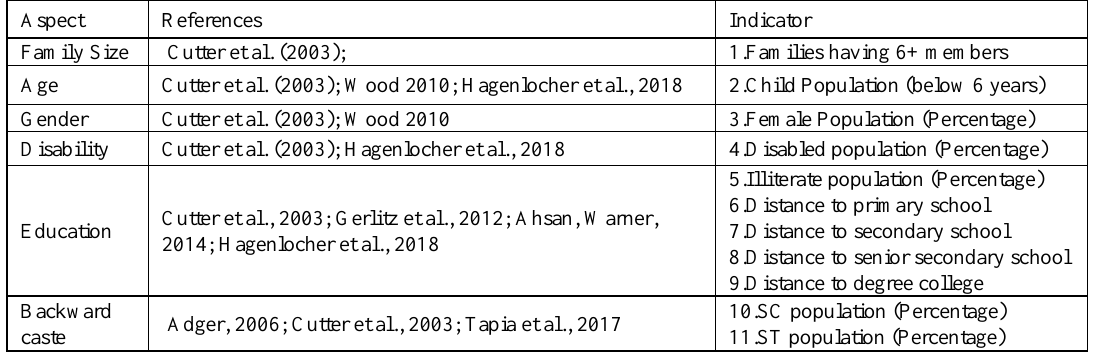
Table 3. Sub-dimensions, indicators and references for social vulnerability.